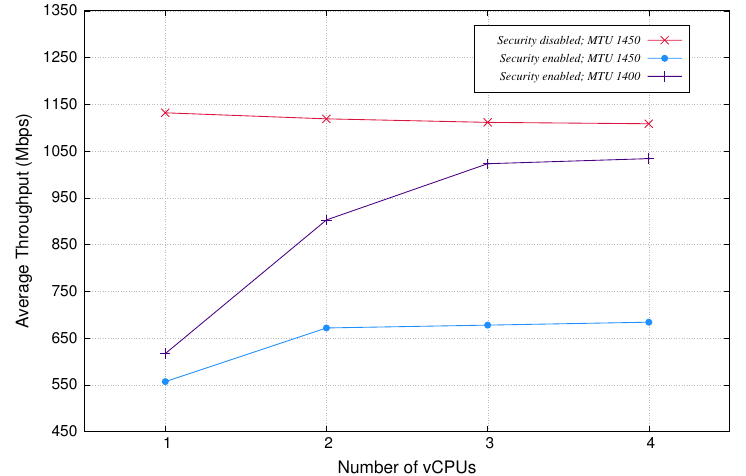
Figure 5. Performance of the L 2 S platform